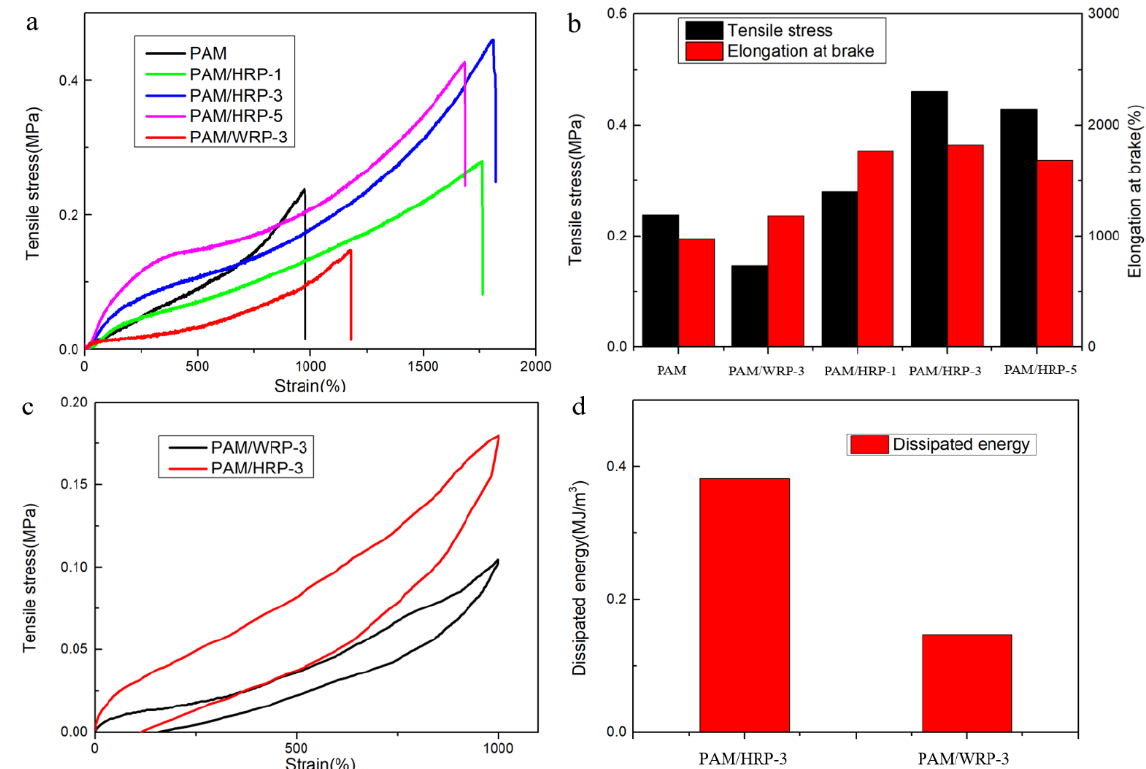
Figure 7. Tensile properties of the PAM/HRP hydrogels ( a ). The tensile strength and fracture strain with different PAM/HRP ( b ). The loading – unloading tensile test of PAM/WRP-3 and PAM/HRP-3 ( c ). The dissipation energy of PAM/HRP-3 and PAM/WRP-3 at 1000% strain ( d ).